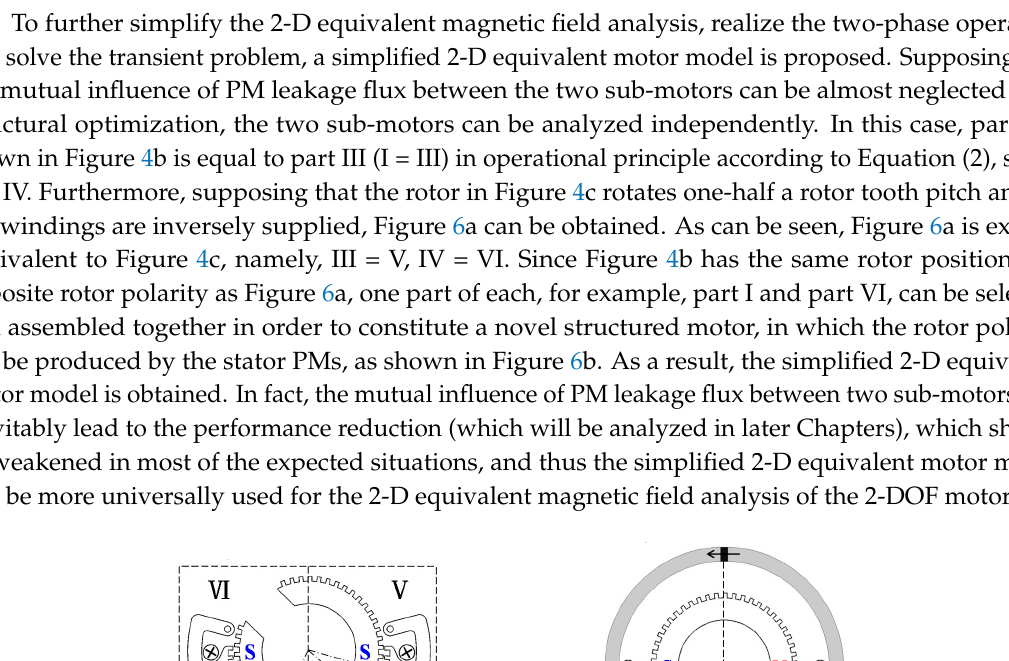
Figure 6. Simplified 2-D equivalent motor model of sub-motor1. ( a ) Equivalent form of Figure 4c; ( b ) The simplified 2-D motor model corresponding to part I + VI.